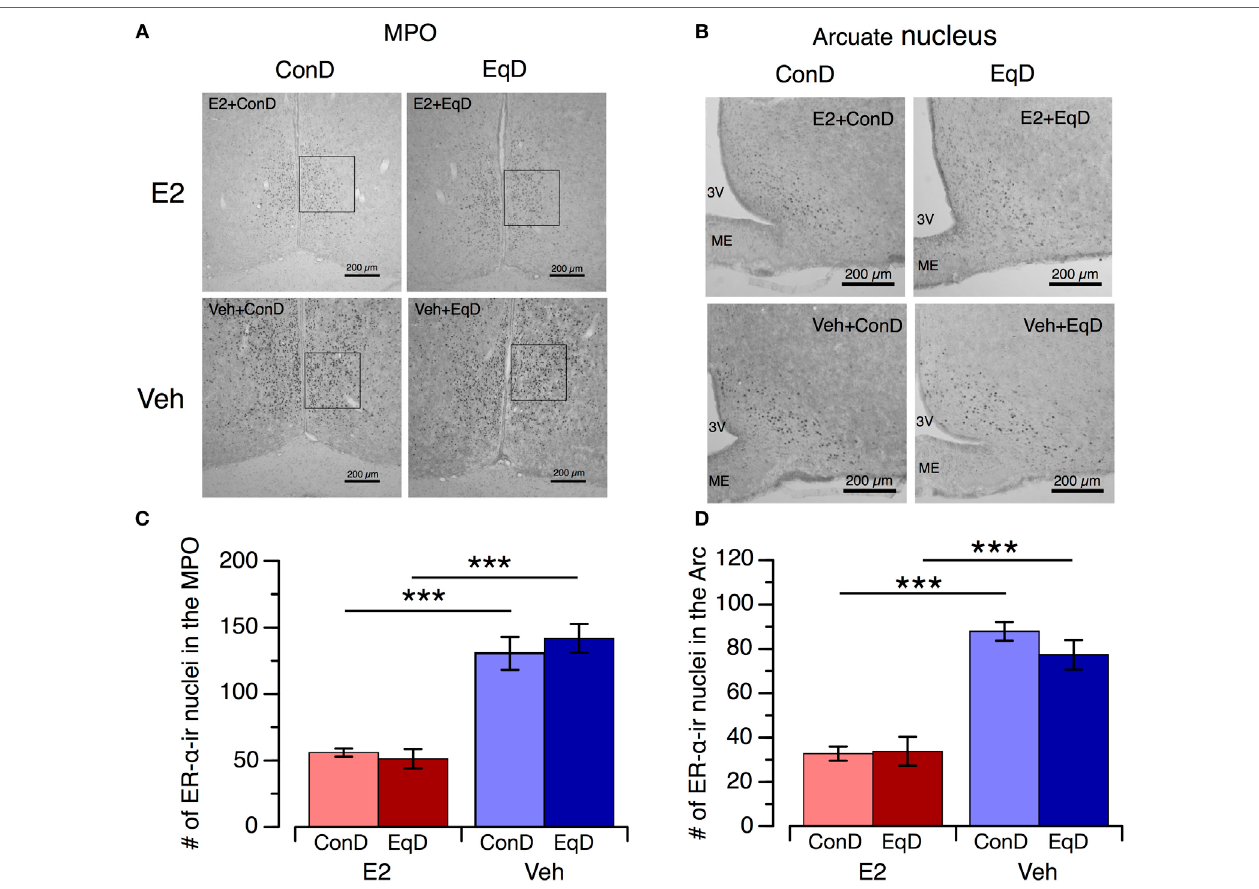
FigUre 5 | The effect of estradiol (E2) replacement and dietary S -equol on estrogen receptor- α (ER- α ) expression in the medial preoptic area (MPO) and arcuate nucleus (Arc). Samples were obtained on the 13th day after ovariectomy. Rats were ovariectomized and assigned to the E2-replaced or cholesterol [vehicle (Veh)]-treated group. These rats were fed a standard (control) diet (ConD) or an S -equol-containing diet (EqD). Samples were obtained on the 13th day after ovariectomy. (a,b) Representative light microscopy images of ER- α -immunoreactive (ir) nuclei in the MPO (a) and Arc (b) in estradiol-replaced (E2) and vehicle- treated (Veh) rats fed a control (ConD) or an S -equol-containing (EqD) diet. 3 V, third ventricle; ME, median eminence; Scale bars: 200 µm. C and D: the number of ER- α -ir cells in the MPO (c) and Arc (D) . Values are shown as the mean ± SEM ( n = 10 in E2 + ConD; n = 10 in E2 + EqD; n = 11 in Veh + ConD; n = 12 in Veh + EqD). ***, indicates a significant difference ( P < 0.001) between the E2-replaced and Veh-treated rats fed the same